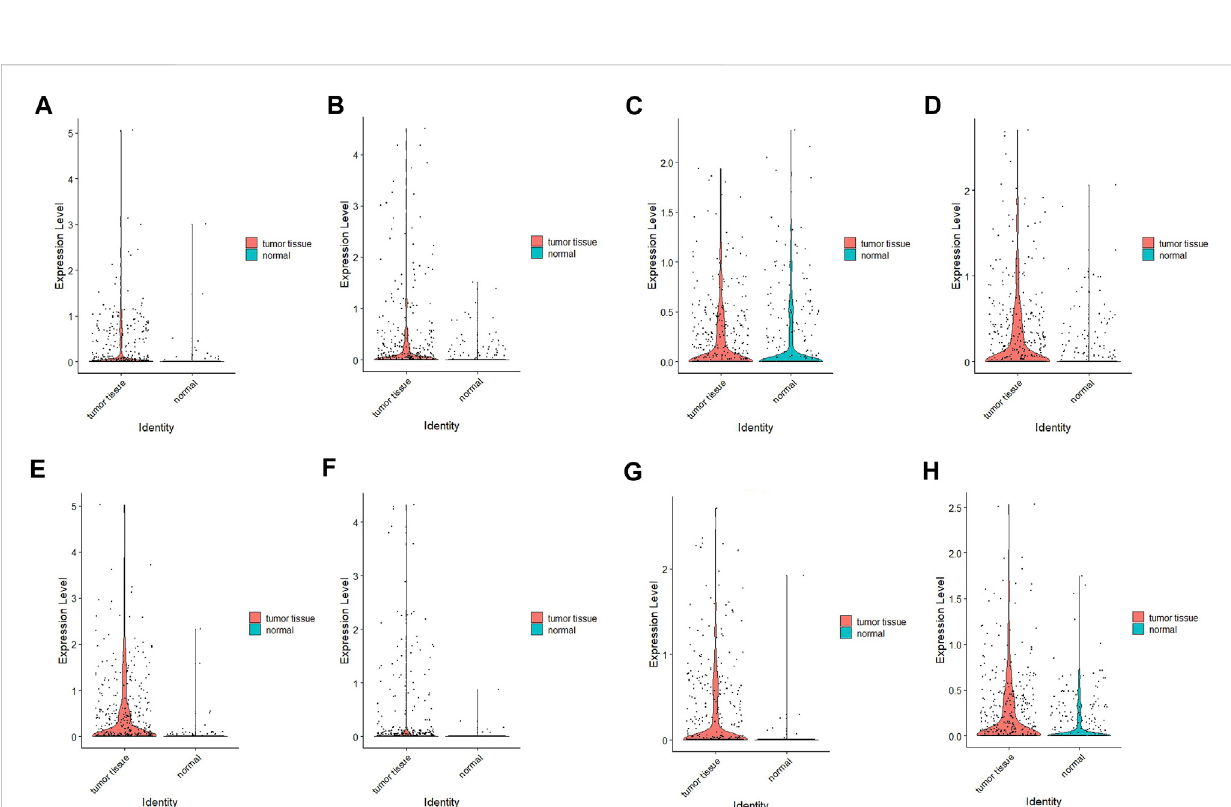
FIGURE 15 Veri fi cationresultsoffourhubgenes ’ expressionusingscRNA-seqdata. (A) COMP; (B) FLNC; (C) ITGB5, (D) LAMC1, (E) THBS1, (F) THBS4, (G) VEGFB, (H) VWF.